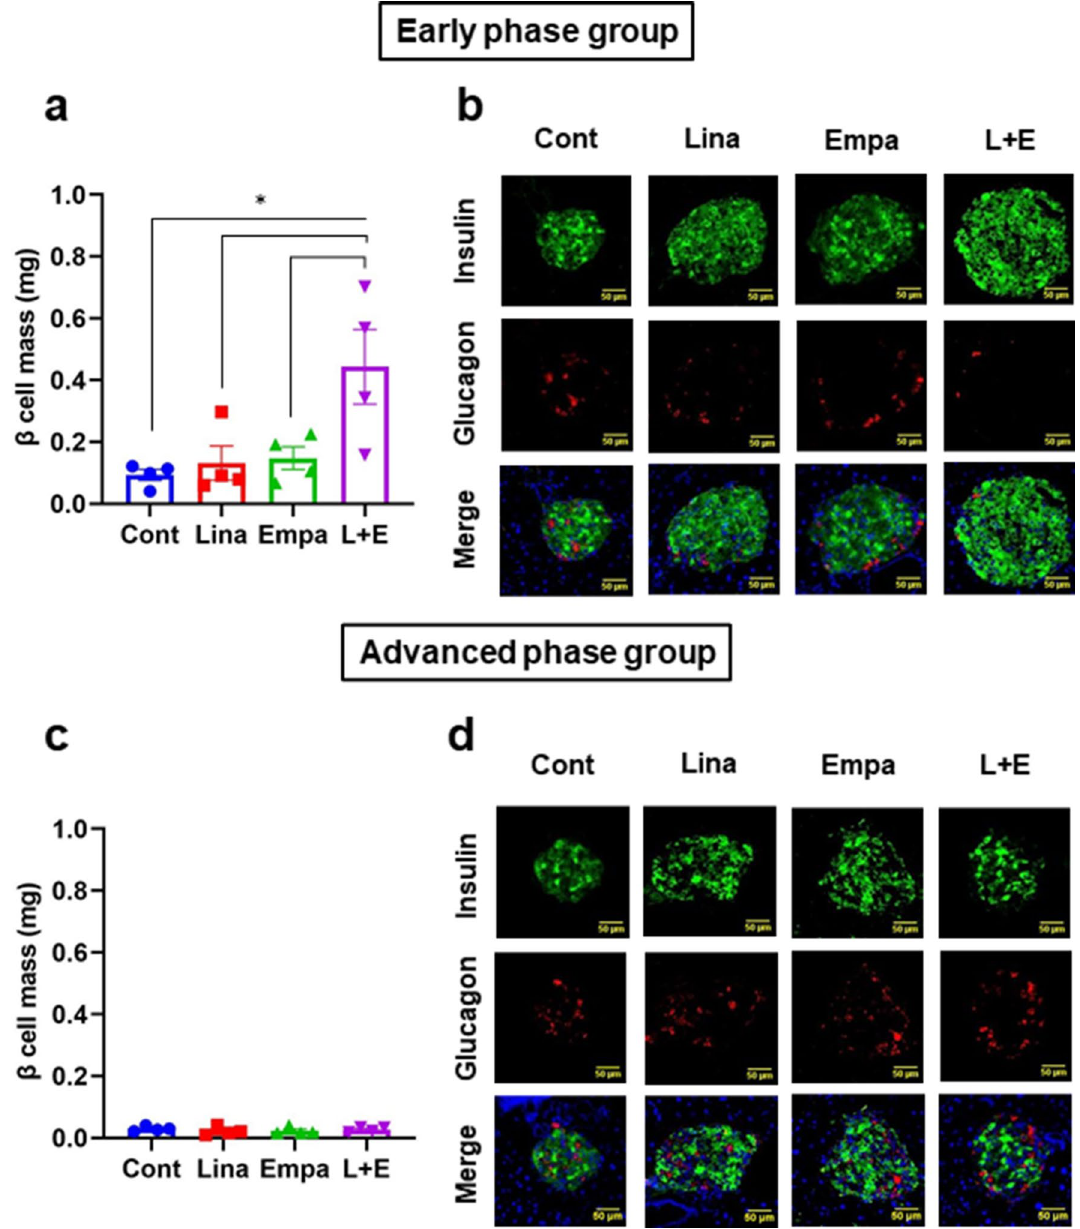
Figure 3. Pancreatic β-cell mass after 2-week treatment in ( a ) an early phase and ( b ) an advanced phase of diabetes (n = 4). ( b , d ) Representative immunofluorescent images of insulin (green) and glucagon (red) in pancreatic islet tissue sections. Scale bars: 50 μm. The multiple comparison was performed using the Tukey– Kramer method. Data are presented as mean ± S.D. *: p <